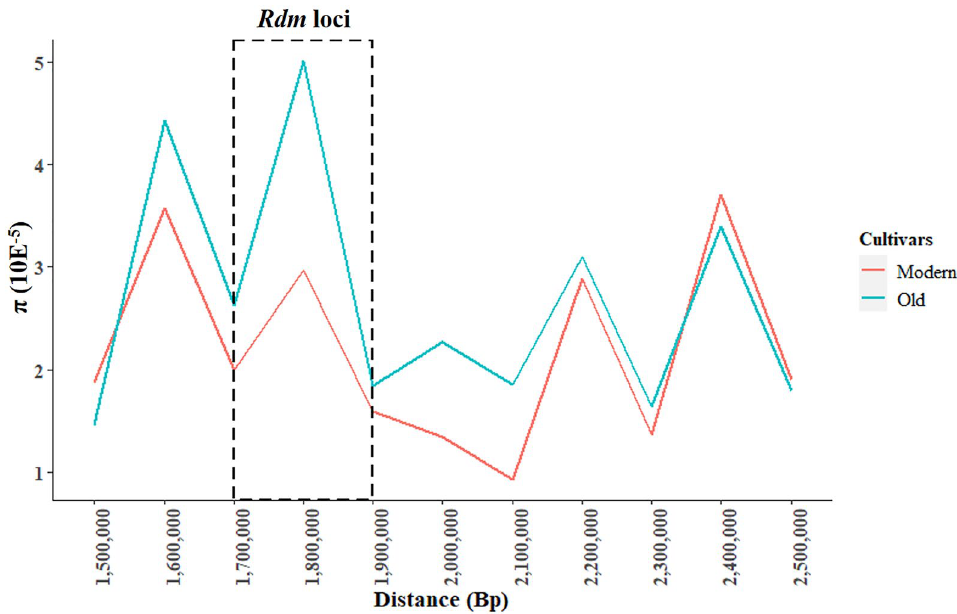
Figure 6. Nucleotide diversity (π) between modern and old cultivars of the southern stem canker resistance loci ( Rdm